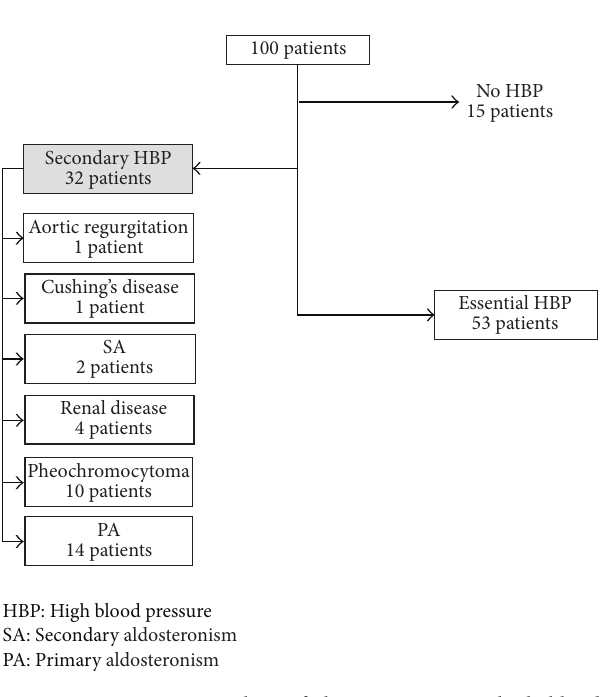
NMR, and one case (1%) of isolated systolic HBP with documented aortic